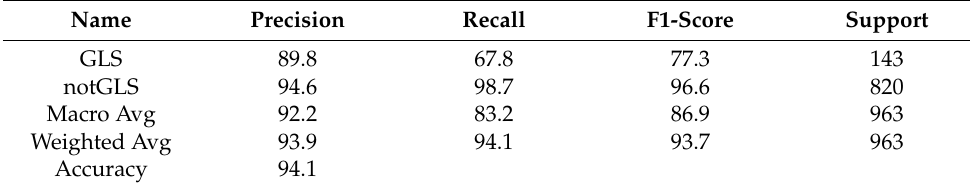
Table 7. Performance of GLS_net_pv upon the PV testing set.